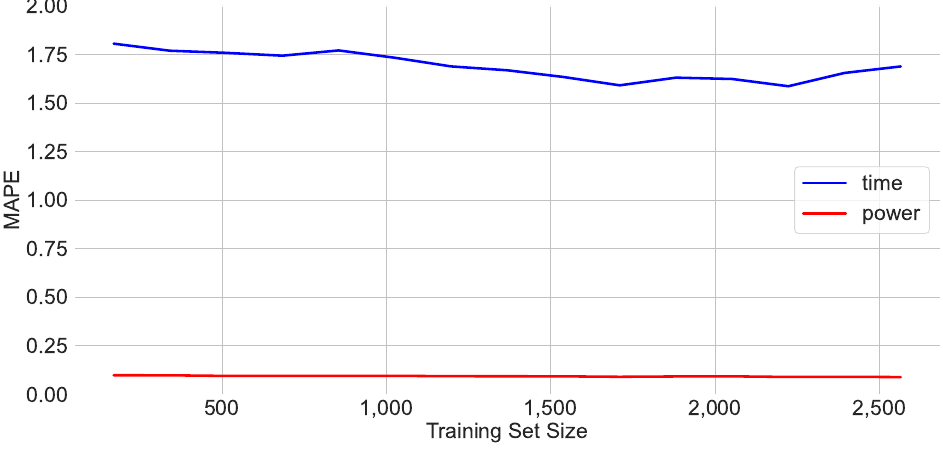
Figure 6. The development of the MAPE scores for the dense workload performance metrics on the Core-i7 4790 with an increasing training set